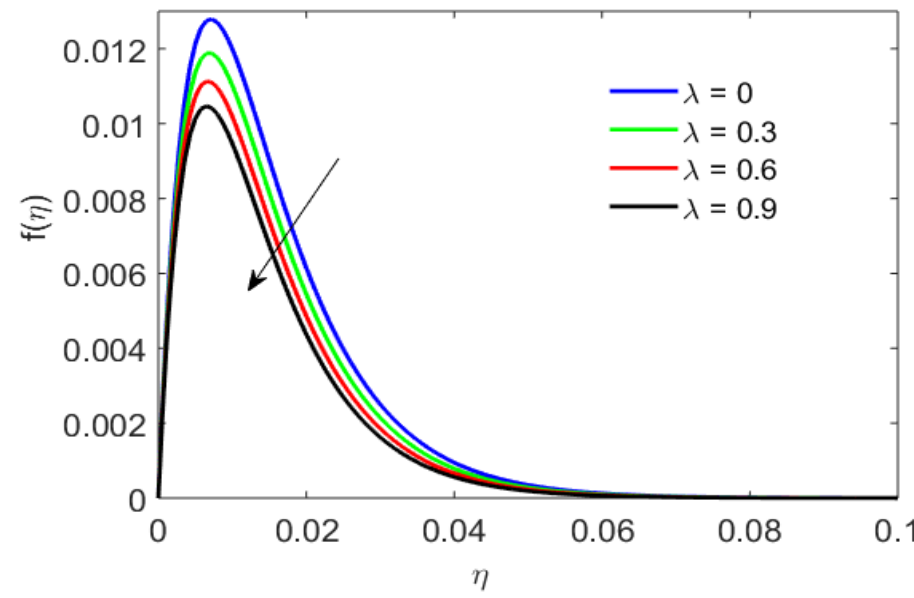
Figure 5. Radial velocity versus porosity parameter.